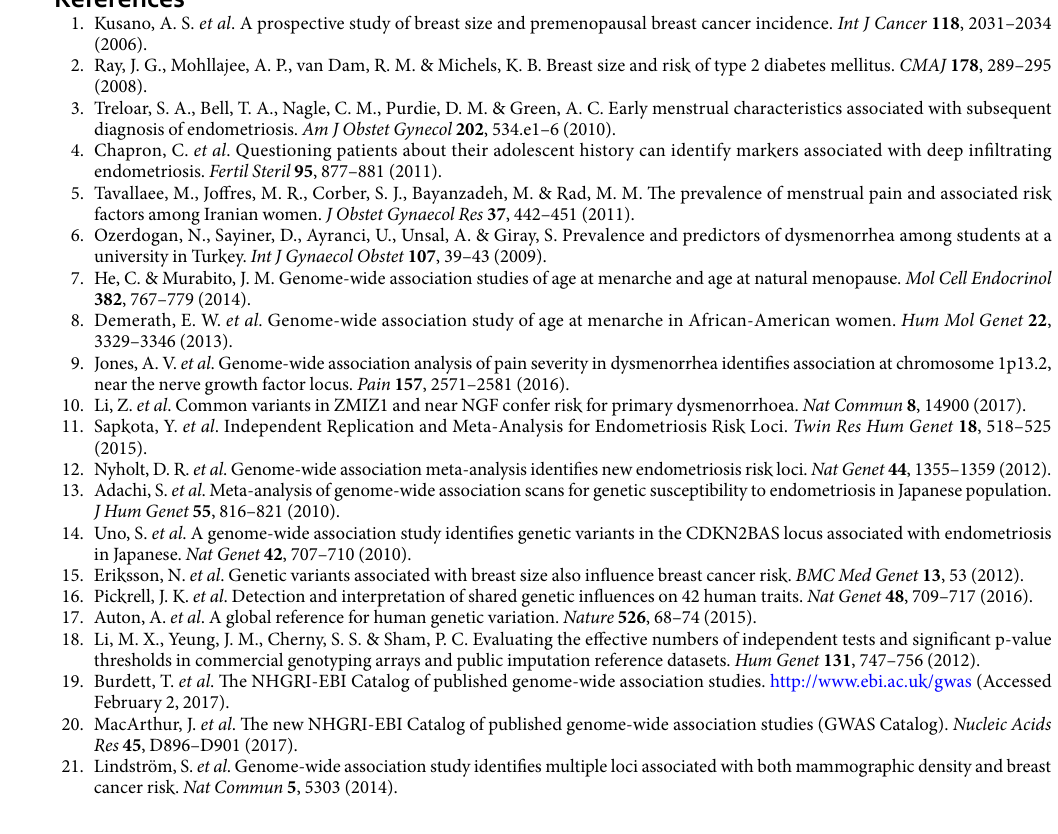
Figure plotting. Self-written R programs were used to produce many figures, with others done using outside software/web-services. Epigenetic state plots were made using RoadMap Epigenomics data from the Washington University Epigenome Browser (http://epigenomegateway.wustl.edu/browser/) 105 and their publication quality image “Screenshot” function. GENCODE V19 106 was used to plot gene transcript models. Custom tracks for top SNPs in association signals were plotted from uploaded BED files. The imputed 25-state model from the RoadMap Epigenomics Project is plotted as an epilogos visualization. The Epilogos custom track: http://egg2. wustl.edu/roadmap/data/byFileType/chromhmmSegmentations/ChmmModels/epilogos/imputed/qcat.gz. GTExPortal (https://www.gtexportal.org/home/) plotting functions were used to make figures of GTEx Project gene expression and eQTL